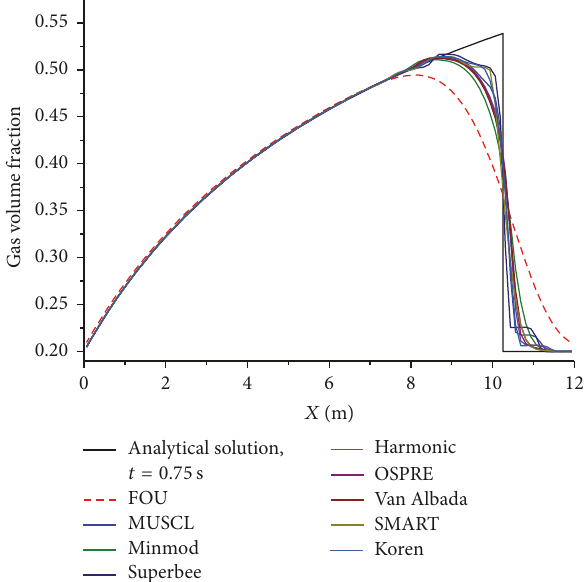
Figure 10: Gas volume fraction comparison between analytical solutions and numerical solutions using high-resolution TVD schemes with 96 cells at time of 0.75 seconds.